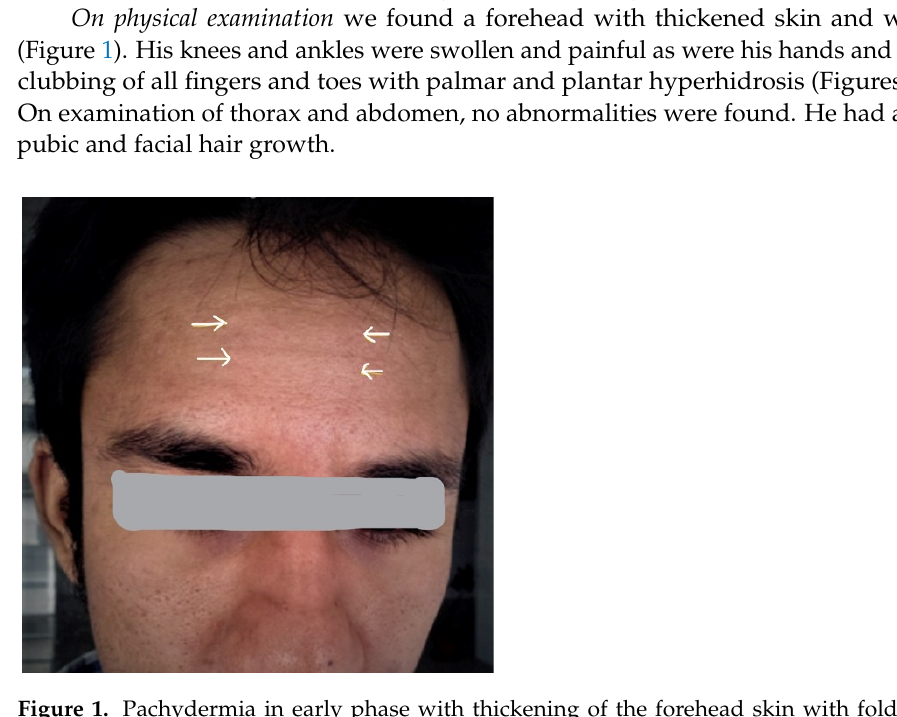
Figure 1. Pachydermia in early phase with thickening of the forehead skin with folds, marked with arrows.